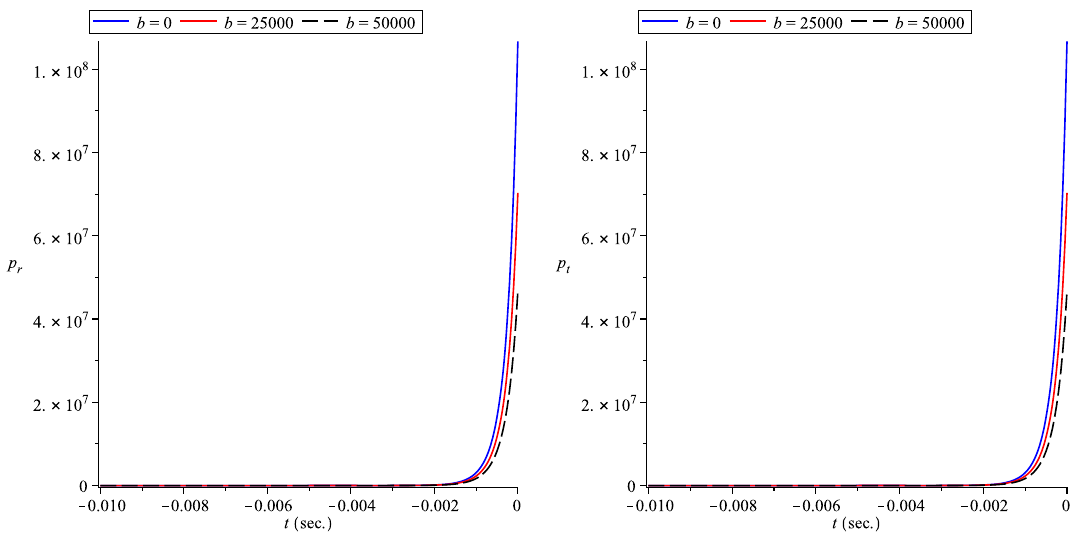
Fig. 3 (Left) plot of heat flux q vs. t for different charge/mass ratios. The charge causes subdued evolution of heat flux. (Right) evolution of density (cid:5) vs time t for different charge/mass ratios. The delay in density blow-up indicates delay in black-hole formation